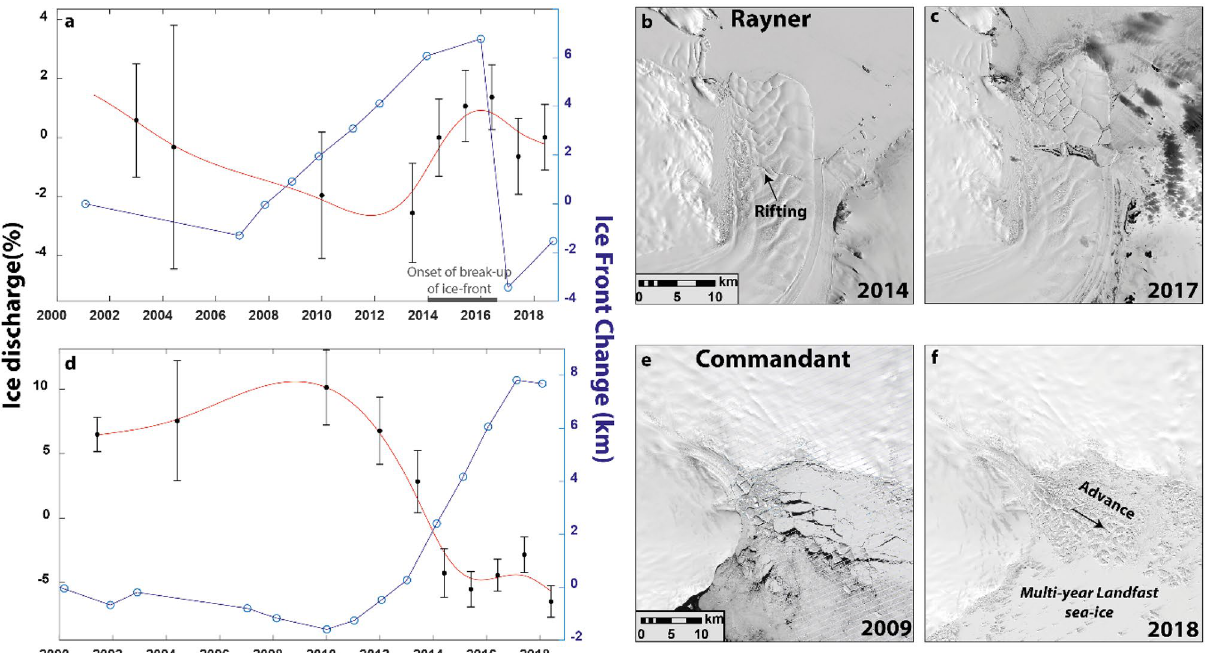
Figure 6. ( a ) Time-series of ice discharge change (%) and ice-front position change between 2000 and 2018 for Rayner Glacier. ( b ) and ( c ) are Landsat-8 images showing the progression of a calving event at Rayner between 2014 and 2017. ( d ) Time-Series of ice discharge and ice-front position change for Commandant Glacier, ( e ) and ( f ) are Landsat-7 (2009) and Landsat-8 (2018) images showing the rapid growth of the Commandant ice tongue in response to persistent landfast sea-ice. The red line in ( a ) and ( d ) are cubic spline trends of ice